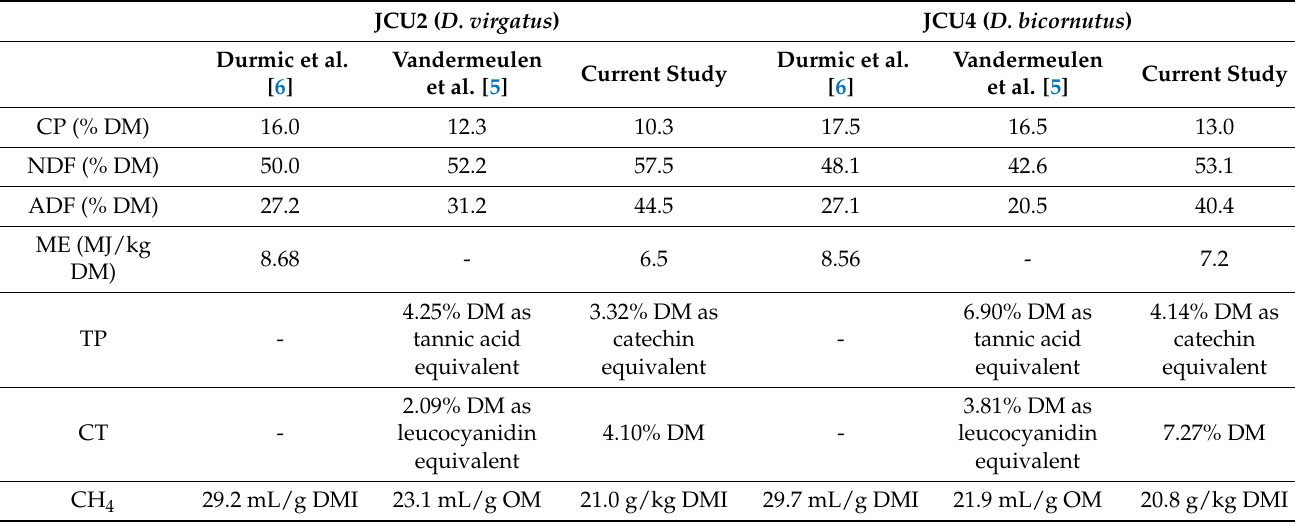
Table 6. Comparison of the chemical composition and methane emissions of JCU2 and JCU4 between the three studies conducted by Durmic et al. [6], Vandermeulen et al. [5] and the current study. JCU2 ( D. virgatus ) JCU4 ( D. bicornutus ) Durmic et al. Vandermeulen Durmic et [6] et al. [5]